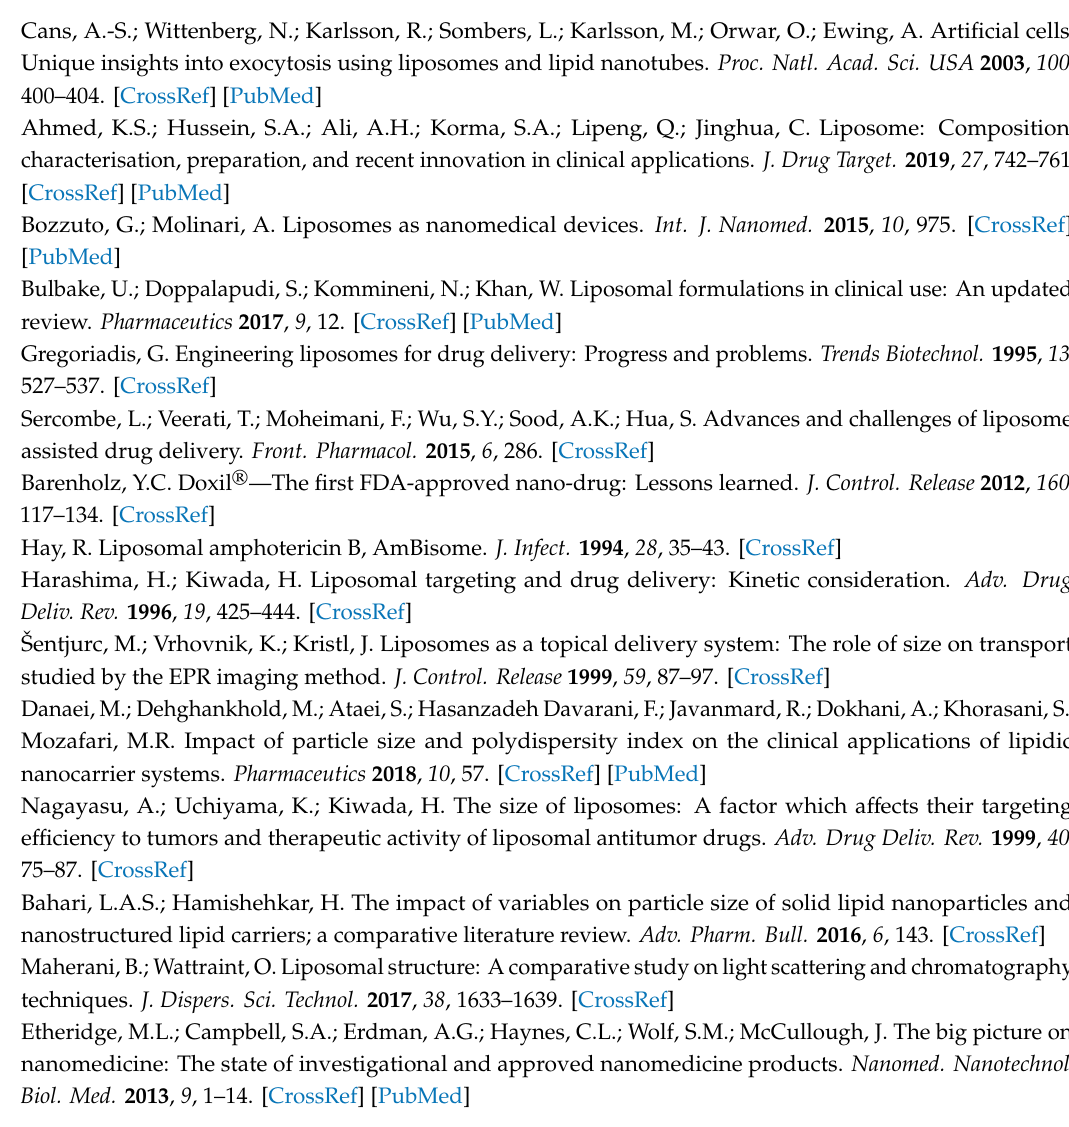
Figure S1. Data represent the viscosity values used in the DLS measurements, Figure S2. The numerically calculated relative mixing index of water and ethanol, based on the selected total flow rates (TFR) and flow rate ratios (FRR), Figure S3. Contour plots of the ethanol mass fraction, plotted over di ff erent cross-sectional surfaces from the entrance of the mixing channel until the channel’s outlet, Figure S4. (A) Shows a representative TEM image used to calculate the liposome diameter, (B) The TEM image was processed using a custom-built software (MATLAB, R2020) that detected the circular objects (i.e., liposomes) in the image and calculated their diameter, Figures S5–S13. The graphs illustrating liposome size and dispersity for the di ff erent experiments carried out in this study, reported over a y -axis range that has been rescaled for each data set, Table S1. Values of Reynolds number and Dean number in the mixing channel of the millifluidic device, at the di ff erent total flow rates (TFR)